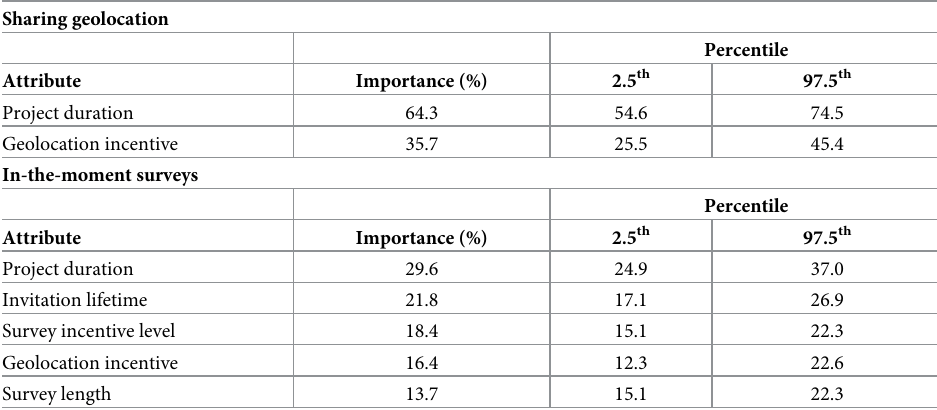
Table 2. Importance of attributes.